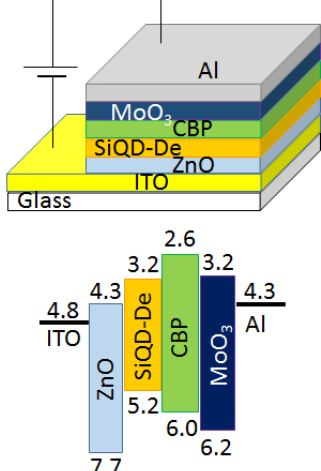
Figure 2. Schematic representation and flat energy band diagram of the pale-orange-light-emitting silicon quantum dot light emitting diode (Si-QLED) with an inverted device structure.